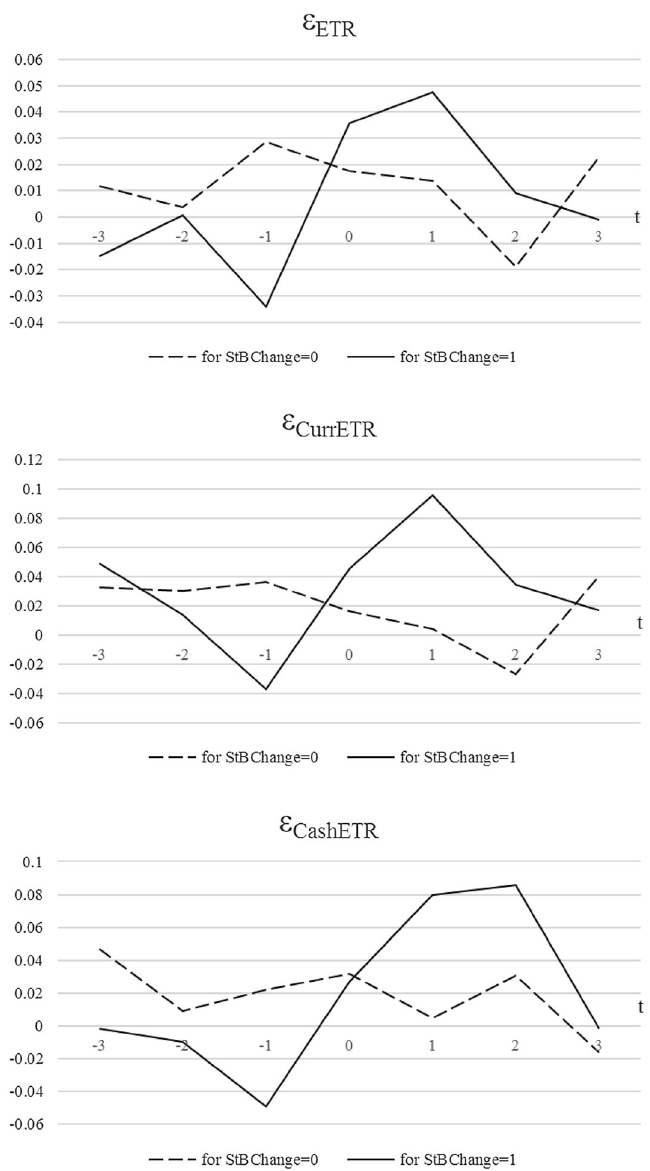
Table 6 Main multivariate findings—tax certified individual auditor